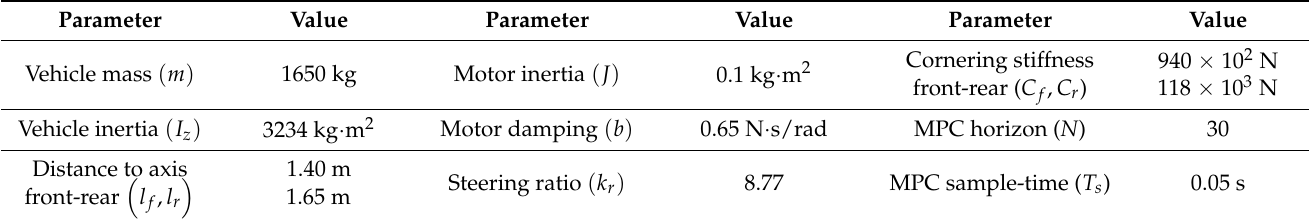
Table 4. NMPC formulation adaptive co-pilot (system